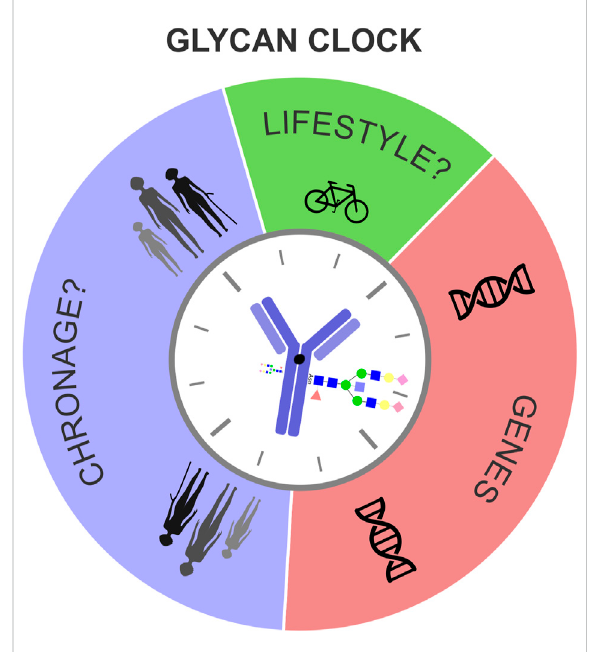
FIGURE 3 Genes, chronological age and lifestyle in fl uence biological agemeasuredbytheglycanclock.Biologicalage,measuredbythe glycan clock is determined by a complex interplay between genetic and environmental factors. Even though the genetic template partly explains the phenotypic variation of the glycan clock this heritability analysis showed how big of a role environment has. Chronological age (ChronAge), that causes biological fatigue, together with fi xed genetic information and unique lifestyle choices dictates the glycan clock